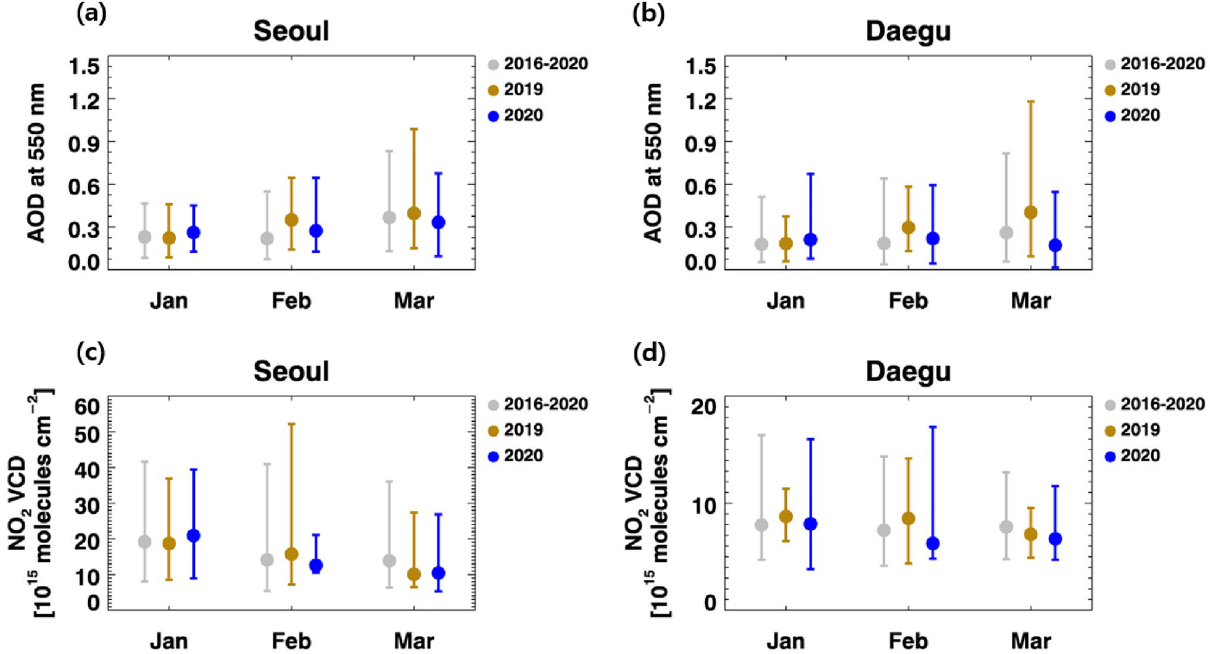
Figure 2. Percentiles of the observed surfaces of the GOCI AOD at 550 nm in ( a ) Seoul and ( b ) Daegu, and OMI NO 2 VCD in ( c ) Seoul and ( d ) Daegu, South Korea for January, February, and March. (The 10th, 50th, and 90th percentiles of January, February, and March are compared for 3 periods: 2016–2020 (gray), 2019 (yellow), and 2020